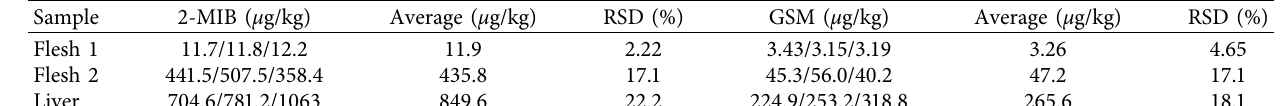
Table 1: Results of the 2-MIB and GSM residues in the incurred samples.